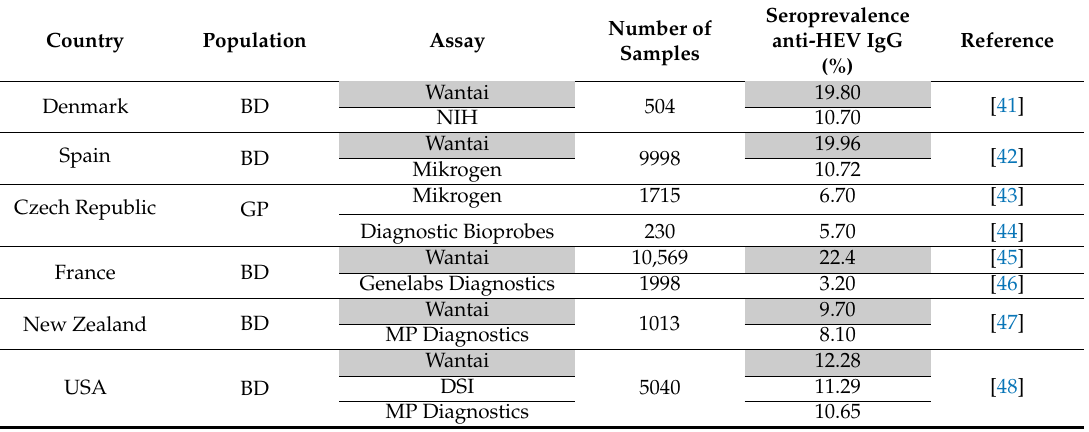
Table 1. HEV IgG prevalences observed when the same population is tested using different assays. Country